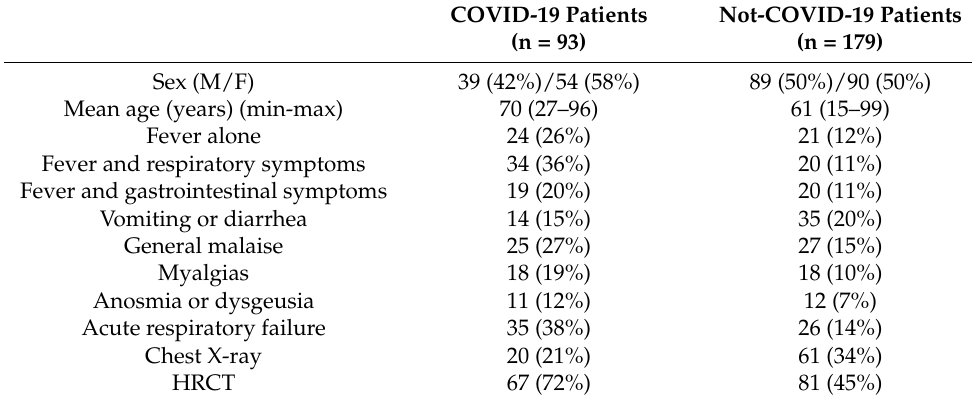
Table 1. Patients’ demographic and clinical characteristics, and radiological tests performed in the ED on admission. M, male. F, female. HRCT, high-resolution computed tomography. Respiratory failure is defined as SpO2 less than 95% at room ambient, 92% for patients with COPD.